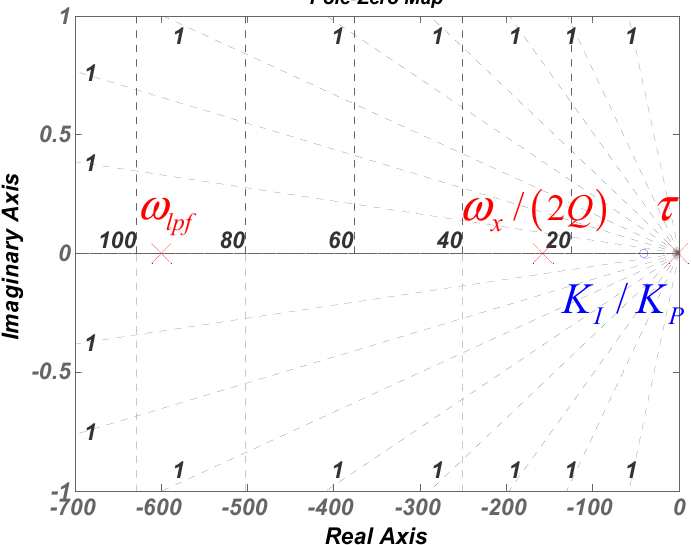
Figure 3. Zero-pole map of the 3rd order velocity-controlled